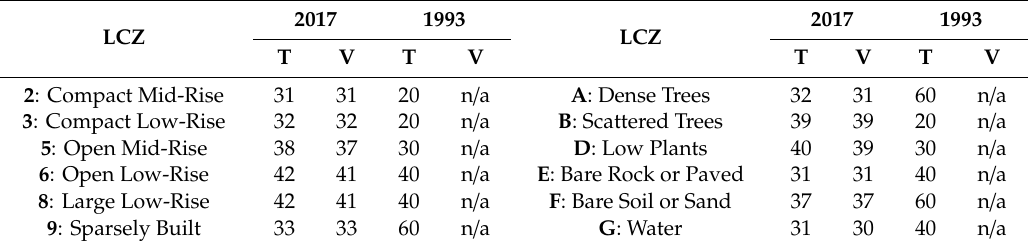
Table 2. Local climate zone (LCZ) classes used in classification and change analysis of the study area. Columns labeled with ‘T’ show numbers of training sample objects, and columns labeled ‘V’ show the number of validation samples (2017